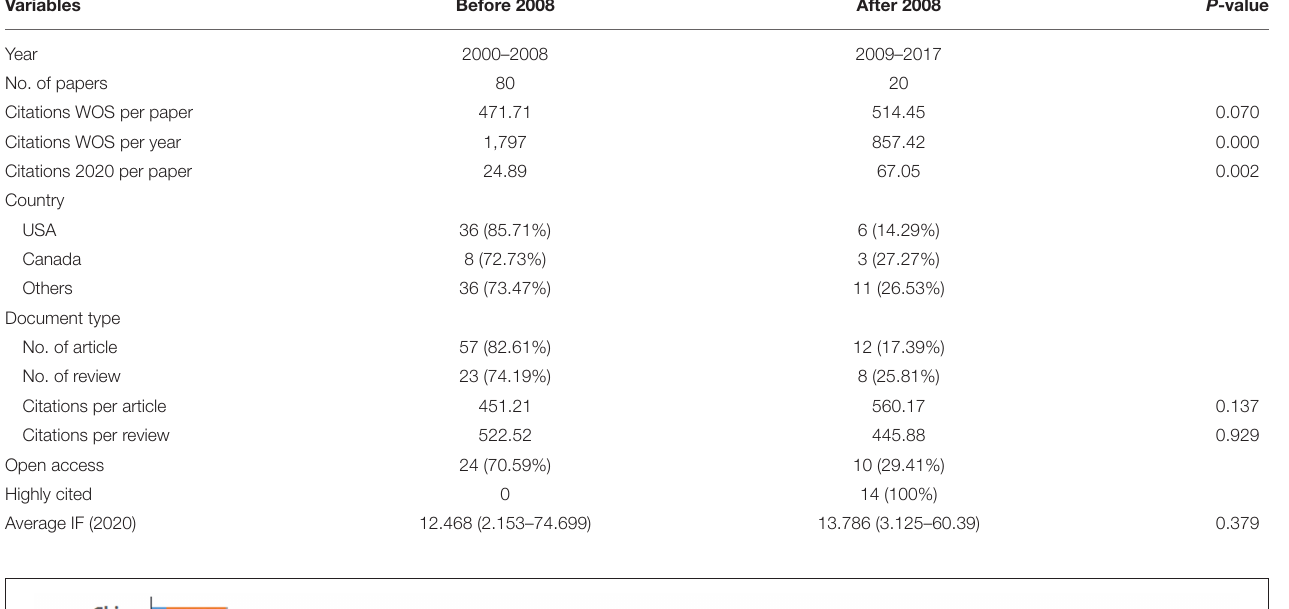
TABLE 2 | Two-time point analyses comparing journals’ top-cited articles before and after 2008. Variables Before 2008 After 2008 P -value